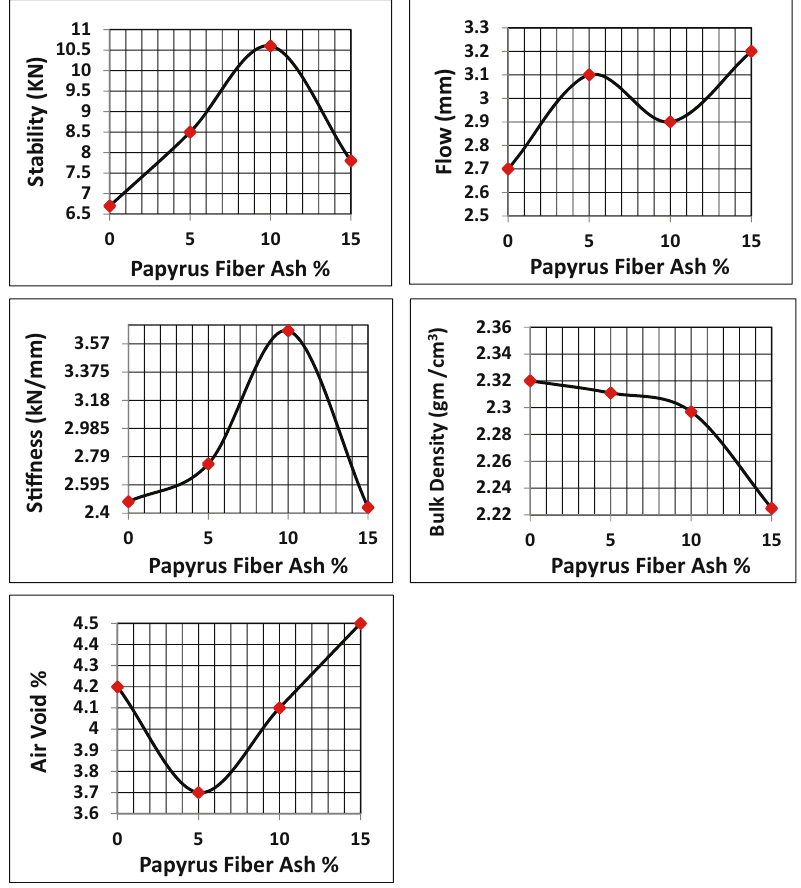
Figure 4: Curves represent the Marshall volumetric